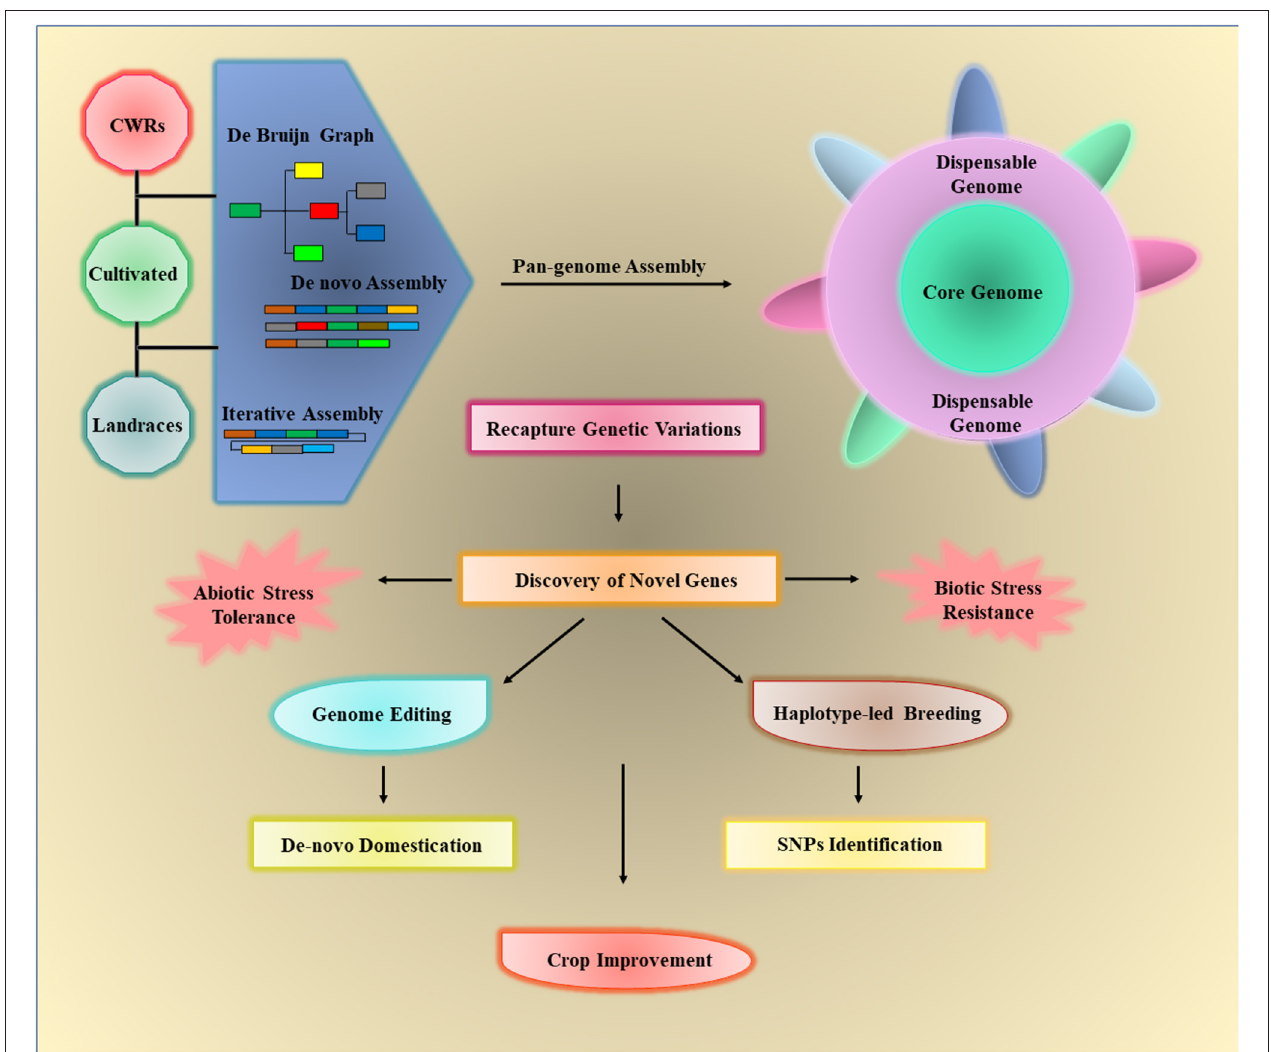
FIGURE 4 | The crop wild relatives (CWRs), landraces, and cultivated varieties of crops can be used to assemble the crop pan-genomes via three approaches such as de novo assembly, de Bruijn graph, and iterative assembly. The core genome includes all the genes of individuals while the dispensable or assessor genome contains all remaining genes, which are not necessary to present in all individuals. Pan-genomes can be used to identify different structural variations (SVs) in any individual and detect novel genes that are lost in cultivated varieties during the breeding process. The elucidation of desired traits/genes can be used for crop improvement by providing biotic/abiotic stress tolerance through haplotype-based breeding and de novo